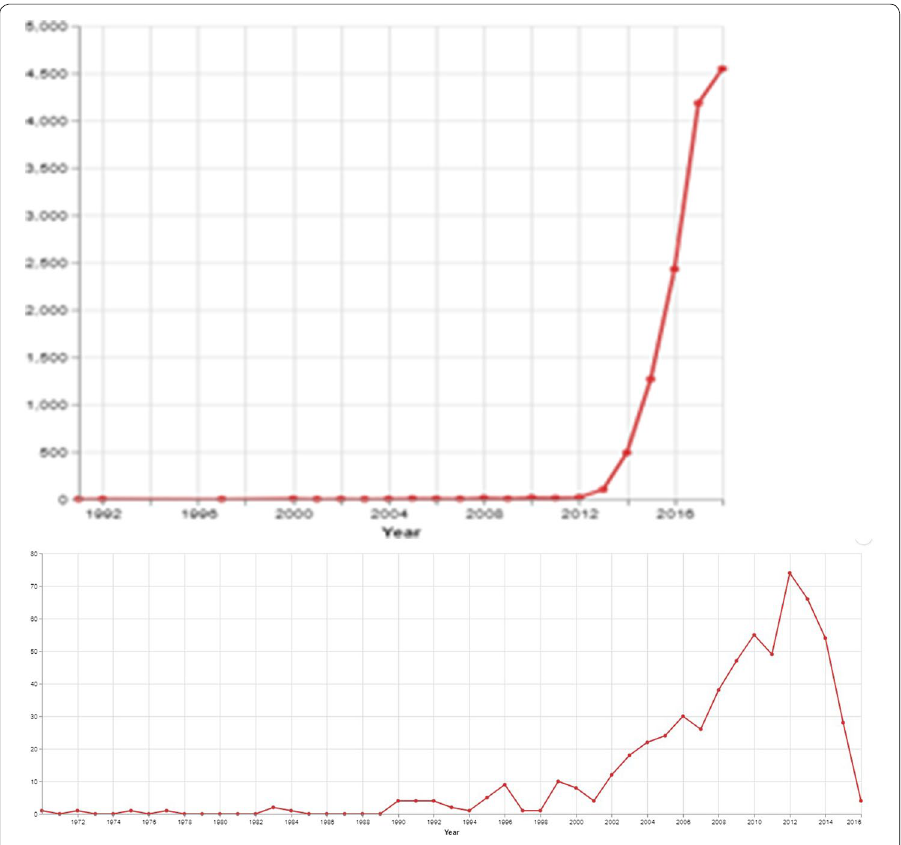
Fig. 3 Temporal evolution of scientific and invention productivity about big data: patent applicants per year (left), and timeline of cited works based on publication year (left)